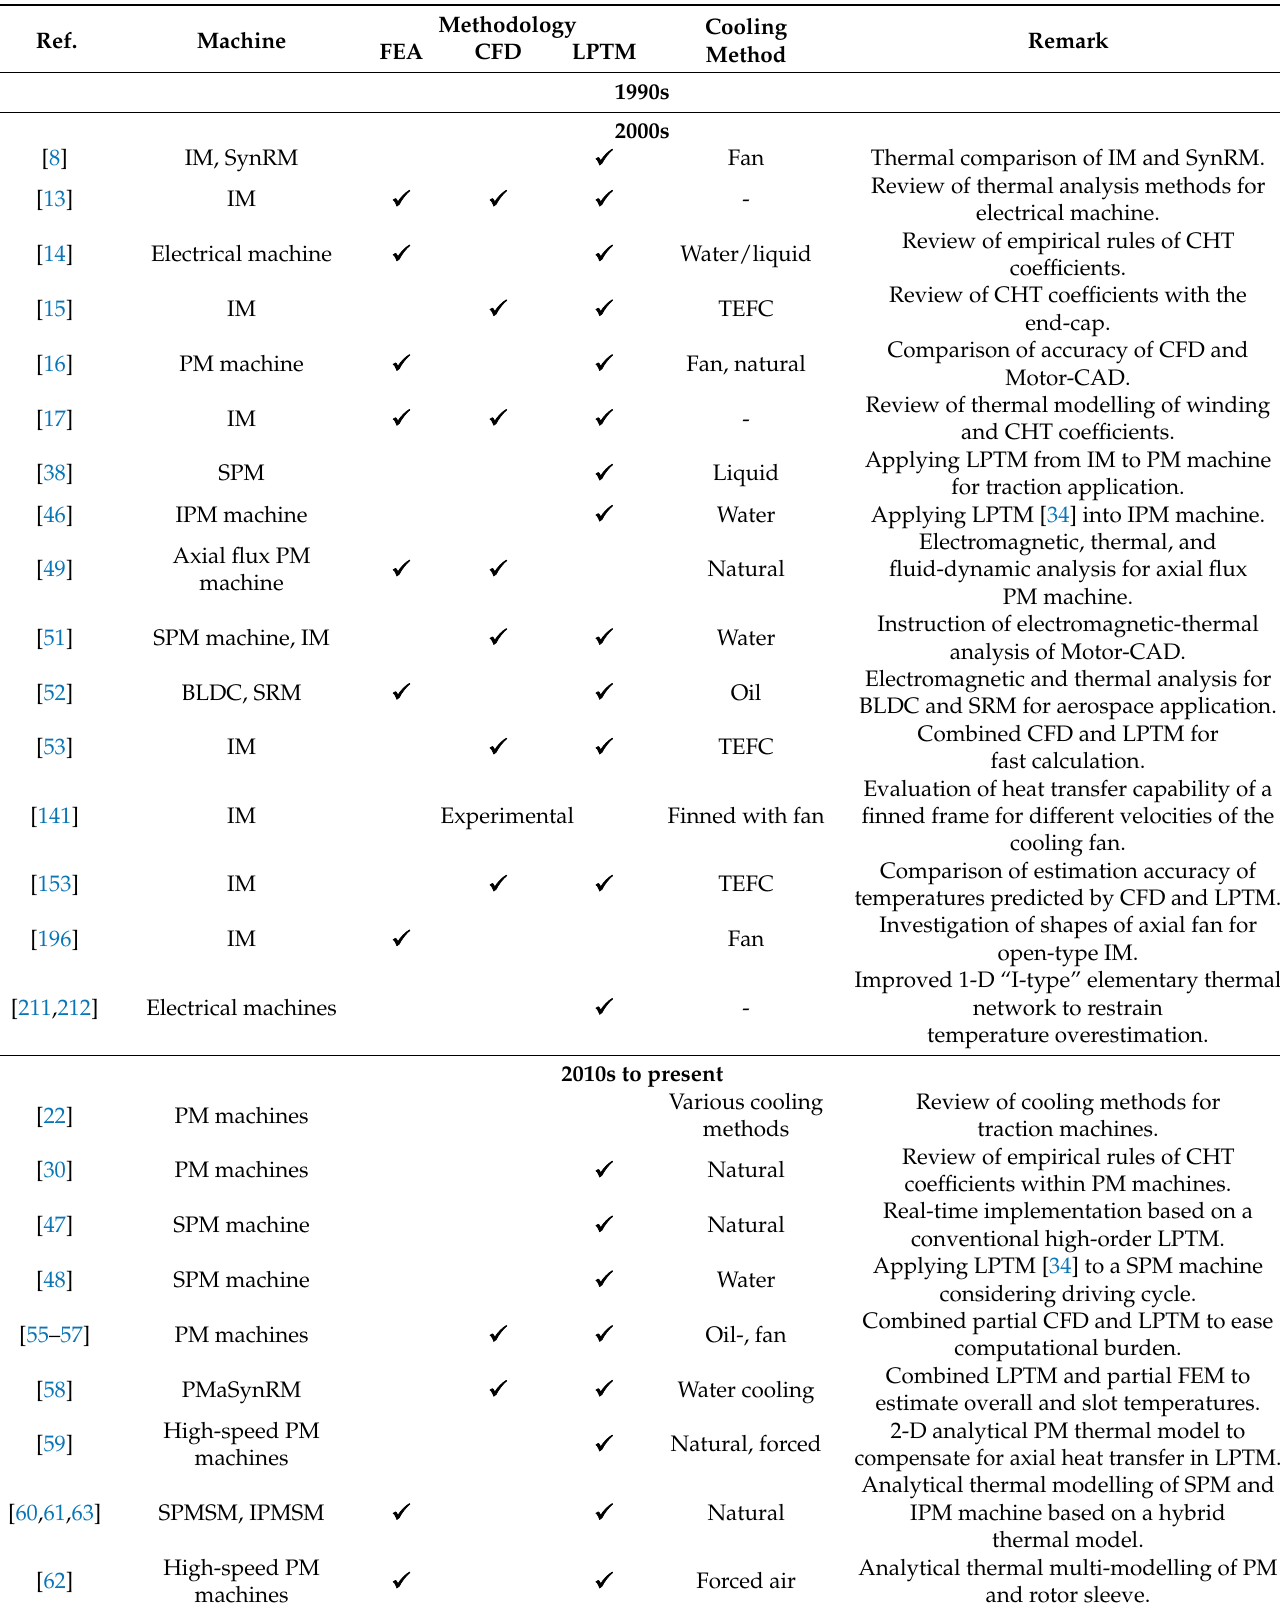
Applying LPTM from IM to PM machine Liquid for traction application.